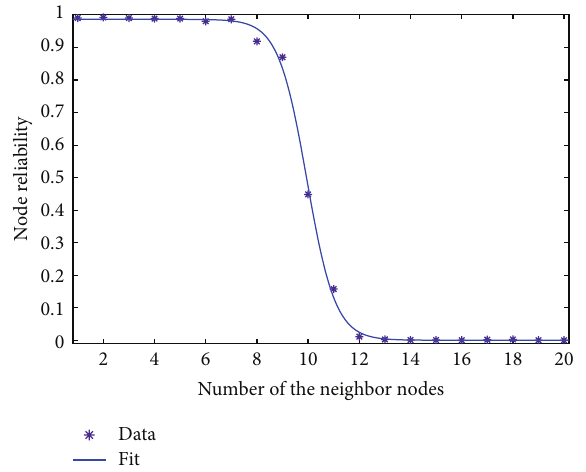
Figure 3: Curve fitting of the node